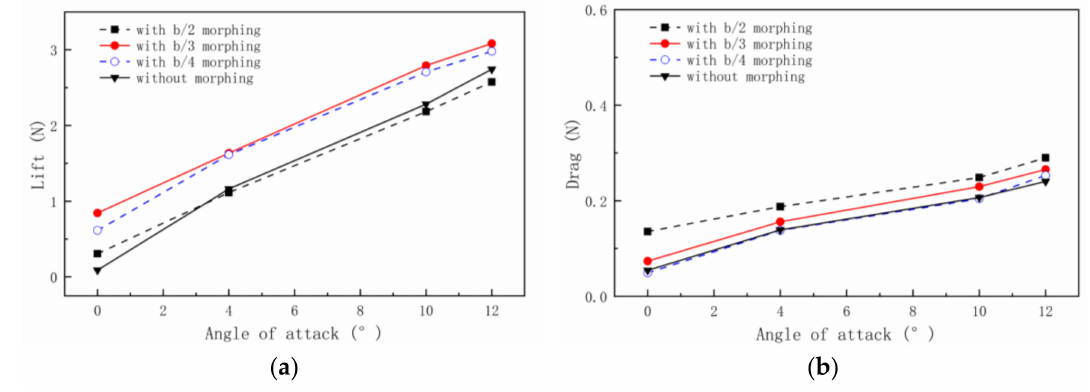
Figure 12. ( a ) Lift force and ( b ) drag force of different wing models at different AOAs.